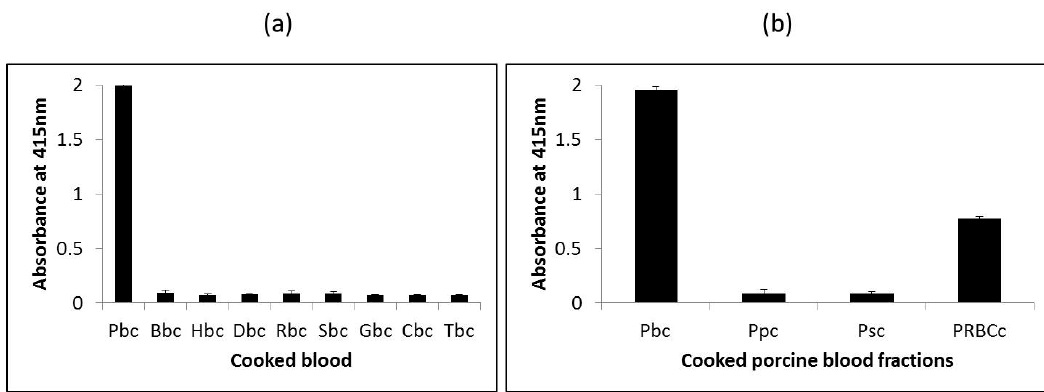
Figure 3. Reactivity of mAb 24C12-E7 with ( a ) cooked blood extracts from nine species and ( b ) cooked porcine blood and blood fractions using iELISA. Soluble proteins extracted from cooked whole blood, plasma, serum or RBCs (red blood cells) were coated at 0.5 µ g per 100 µ L. mAb 24C12-E7 supernatant was diluted 1:50 in 0.2% fish gelatin in PBST . Results are expressed as A 415 ± SD, n = 3. Pbc: cooked porcine blood; Bbc: cooked bovine blood; Hbc: cooked horse blood; Dbc: cooked donkey blood; Rbc: cooked rabbit blood; Sbc: cooked sheep blood; Gbc: cooked goat blood; Cbc: cooked chicken blood; Tbc: cooked turkey blood; Ppc: cooked porcine plasma; Psc: cooked porcine serum; and PRBCc: cooked porcine RBCs.